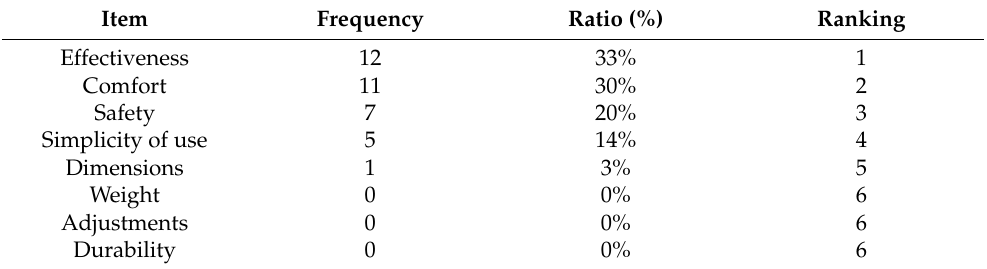
Table 11. Importance of